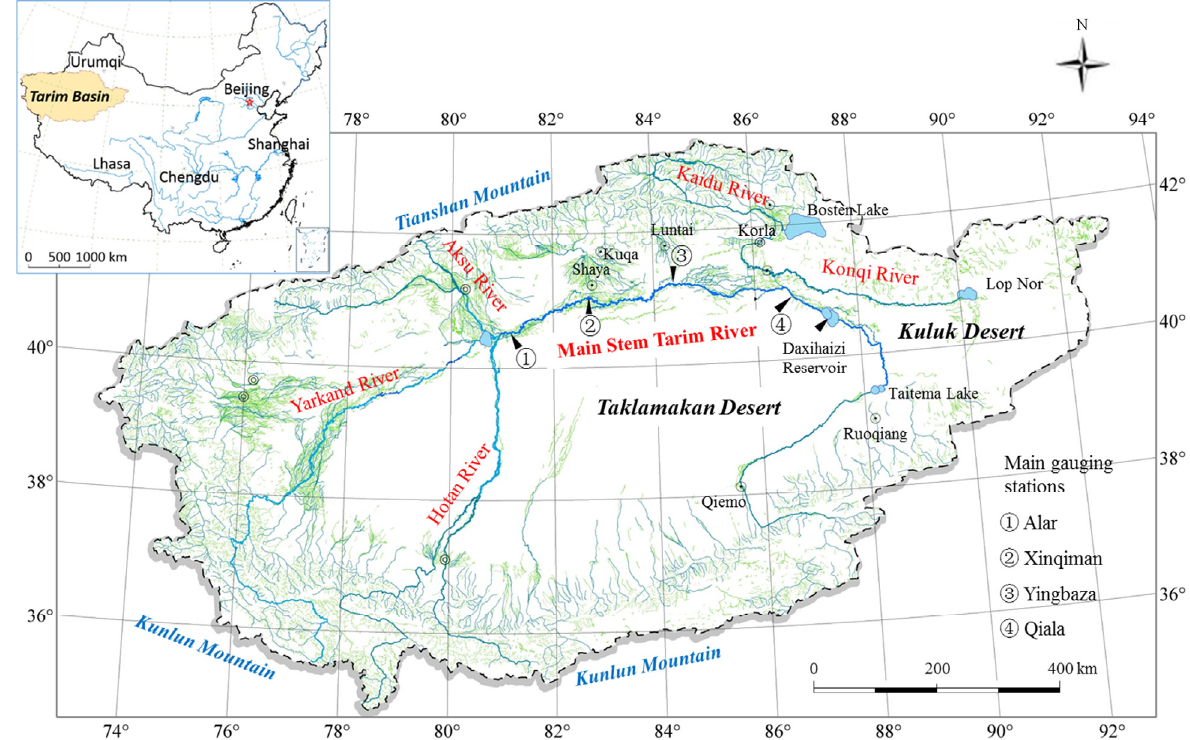
Figure 1. Tarim River basin and main stem river gauging stations.